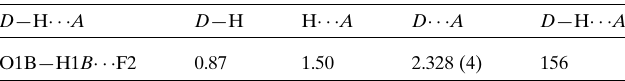
Table 4 Hydrogen-bond geometry (A˚ , (cid:4) ) for